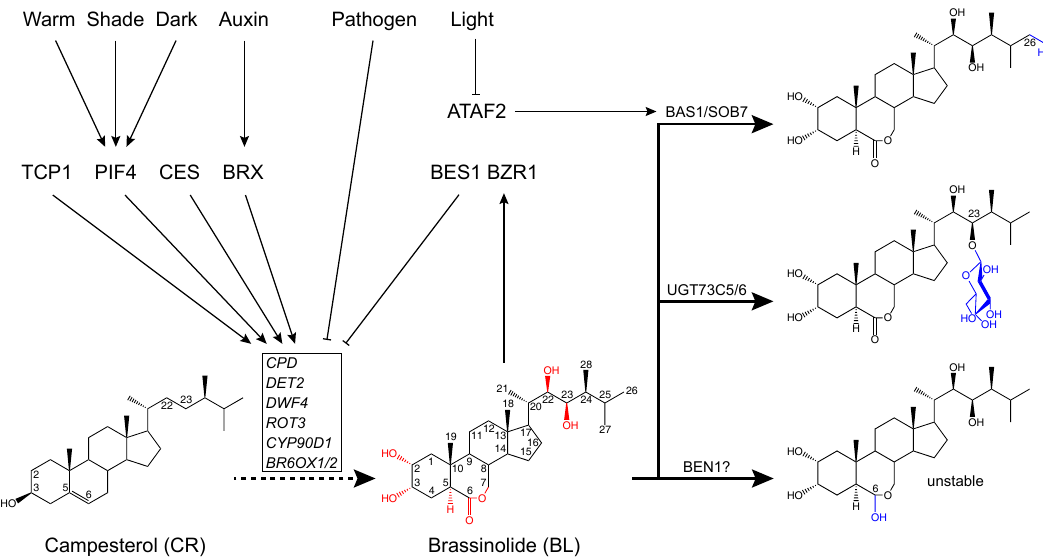
Figure 1. Simplified model of brassinosteroid (BR) homeostasis maintained by biosynthesis, catabolism, and their regulatory networks. Brassinolide (BL), the most active BR, is biosynthesized from the BR-specific precursor campesterol (CR) through a number of catalytic steps. BL can be inactivated via several modifications including hydroxylation, glucosylation, and reduction. BR biosynthetic and metabolic genes are transcriptionally regulated by several internal factors in response to environmental cues. Arrows indicate stimulation, whereas lines with blunt ends represent